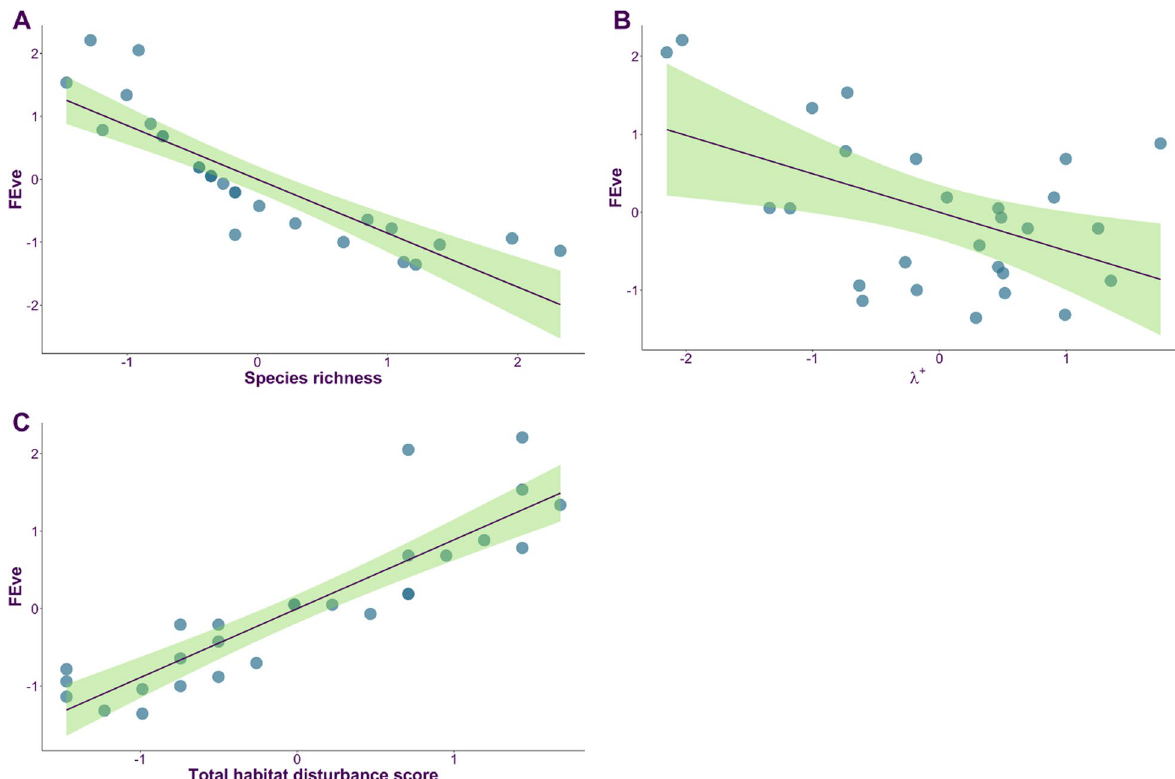
Fig. 6 Scatter plots of the relationship between A functional evenness (FEve) and species richness of spider community (multiple R 2 r 0.855) B functional evenness (FEve) and index of variation in taxonomic distinctness (λ + ) of spider community (multiple R 2 = − r 0494) and C functional evenness (FEve) of spider community and total habitat disturbance score (multiple R 2 = − studied along the Ganga River, India